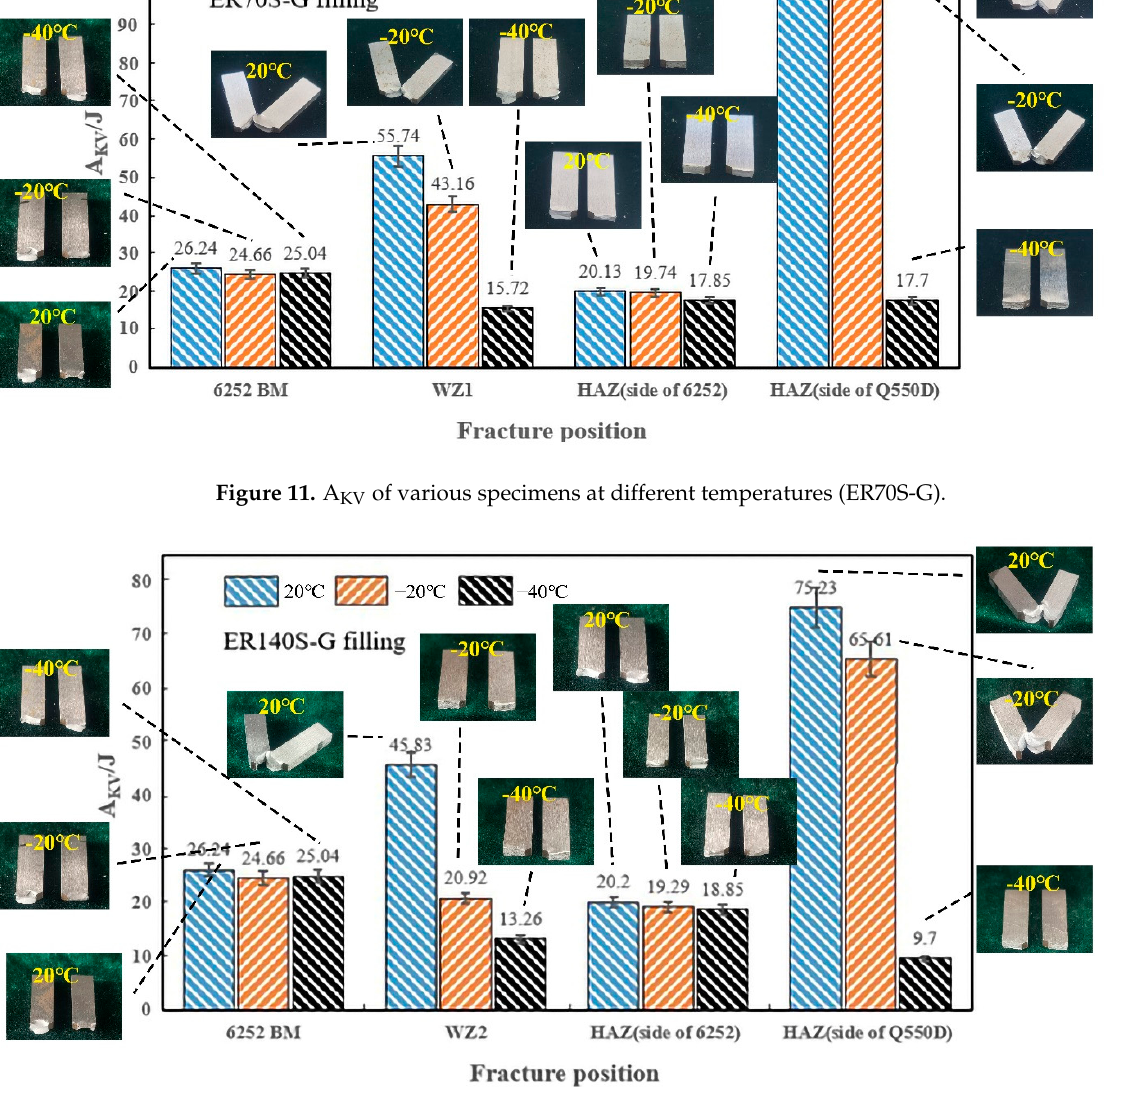
Figure 12. A KV of various specimens at different temperatures (ER140S-G).